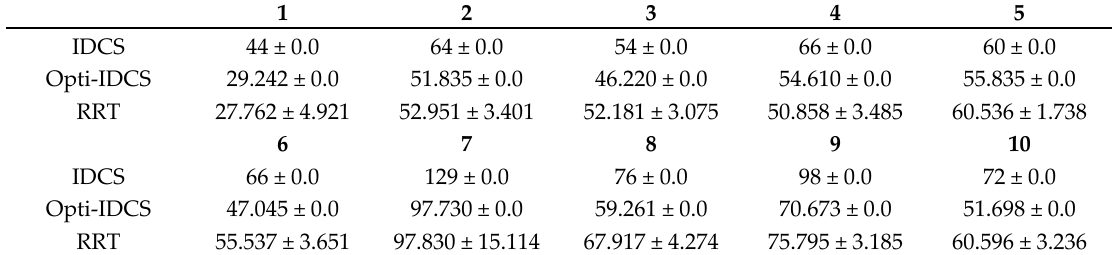
Table 3. Path length in 2D maps.